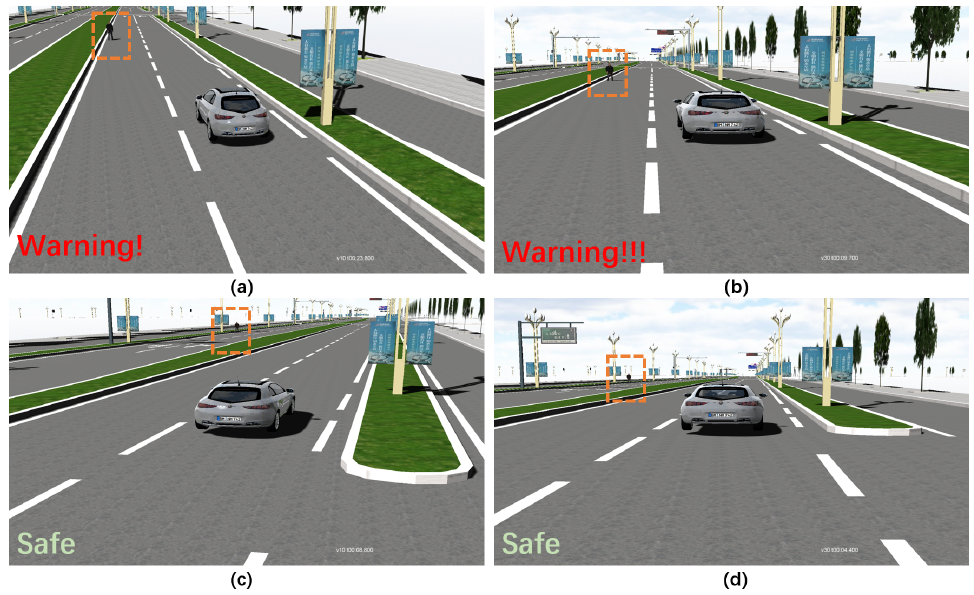
Figure 11. VRUCW test in VTD simulator: ( a ) case 1: Gap = 5 m, HV’s speed = 10 km/h; ( b ) case 2: Gap = 5 m, HV’s speed =30 km/h; ( c ) case 3: Gap = 12 m, HV’s speed = 10 km/h; ( d ) case 4: Gap = 12 m, HV’s speed = 30